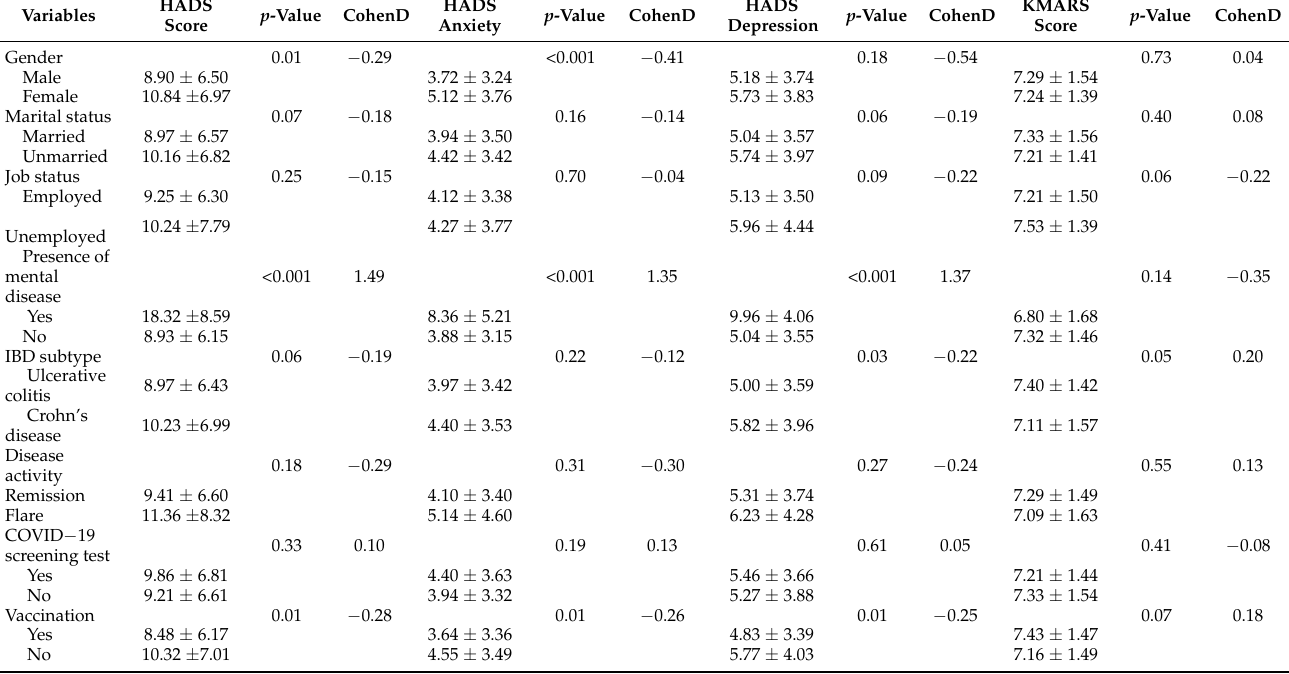
Table 2. Average scores of HADS and KMARS among respondents according to